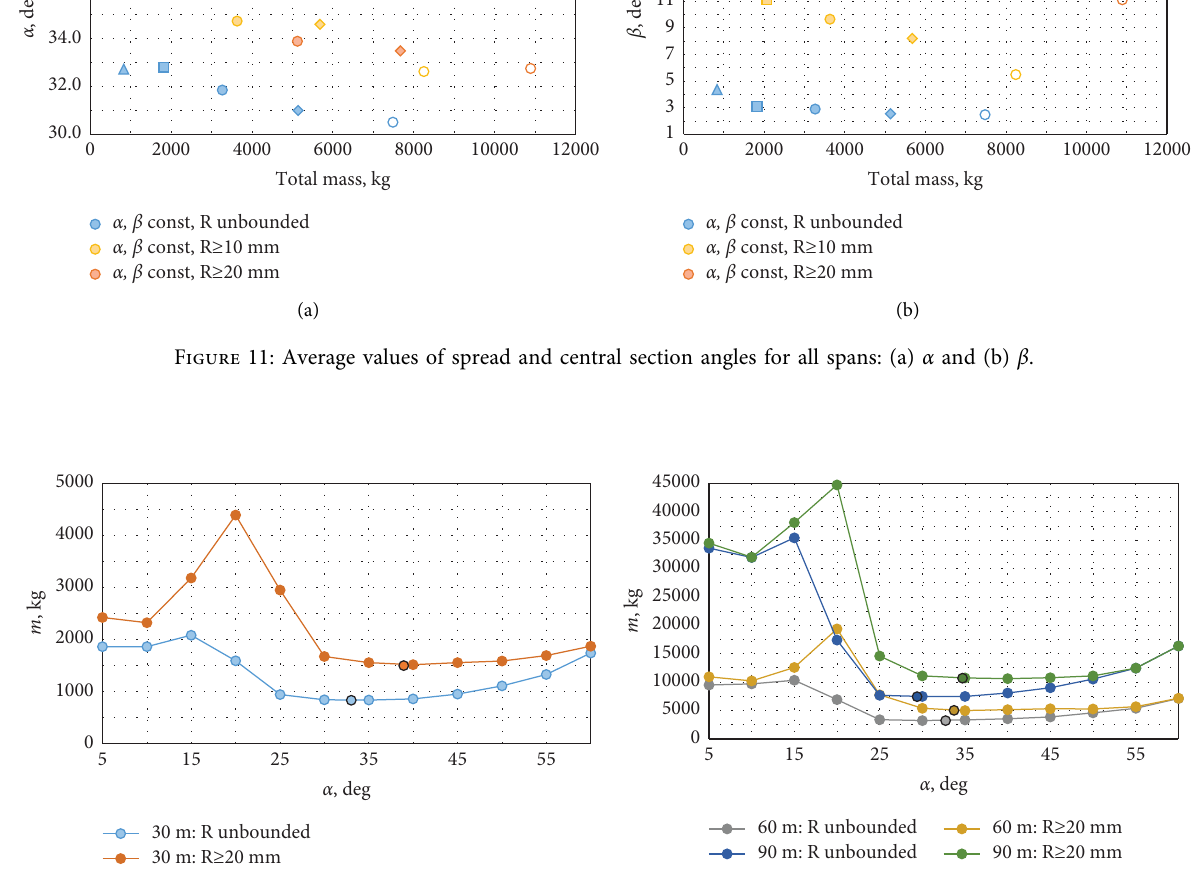
Figure 12: Dependencies of the total bridge mass on the fxed spread angle values for three spans of the bridge.